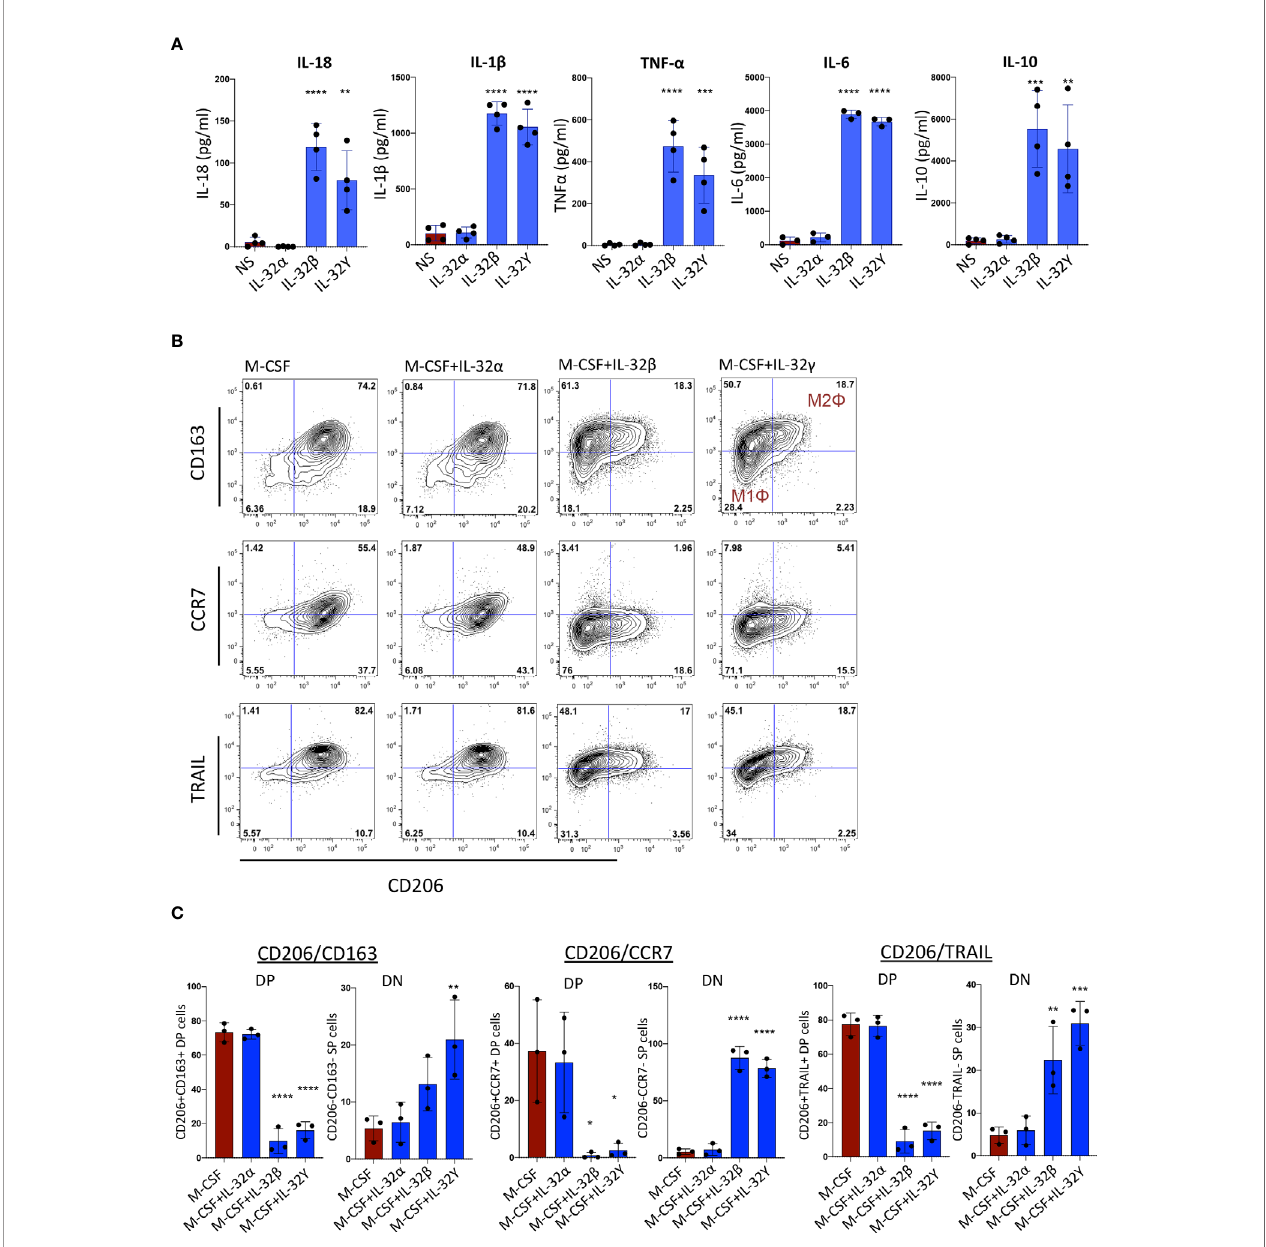
FIGURE 3 | Monocyte activation and differentiation with IL-32 isoforms. (A) Bar graphs showing mean ± standard deviation for cytokine production of IL-18, IL-1 b , TNF- a , IL-6 and IL-10 measured by ELISA from supernatant of monocytes stimulated with IL-32 a , IL-32 b or IL-32 g for 48h (n=4). (B) Flow cytometry analysis showing phenotype of monocytes stimulated with M-CSF in the presence or absence of IL-32 a , IL-32 b or IL-32 g for 3 days (n=3); co-expression of CD206 and CD163 (upper panels), co-expression of CD206 and CCR7 (middle panels) and CD206 and TRAIL (lower panels). Live cells were gated based on Live/dead discriminator and CD14 expression. (C) Graphs showing mean ± standard deviation for the double positive (DP) and double negative (DN) populations for CD206 and CD163 (left panels), CD206 and CCR7 (middle panels) and CD206 and TRAIL (right panels). Data analyzed with ordinary one-way ANOVA and Dunnetts ’ s multiple comparison (*P ≤ 0.05, **P ≤ 0.01, ***P ≤ 0.001, **** P ≤ 0.0001). NS, Non-stimulated